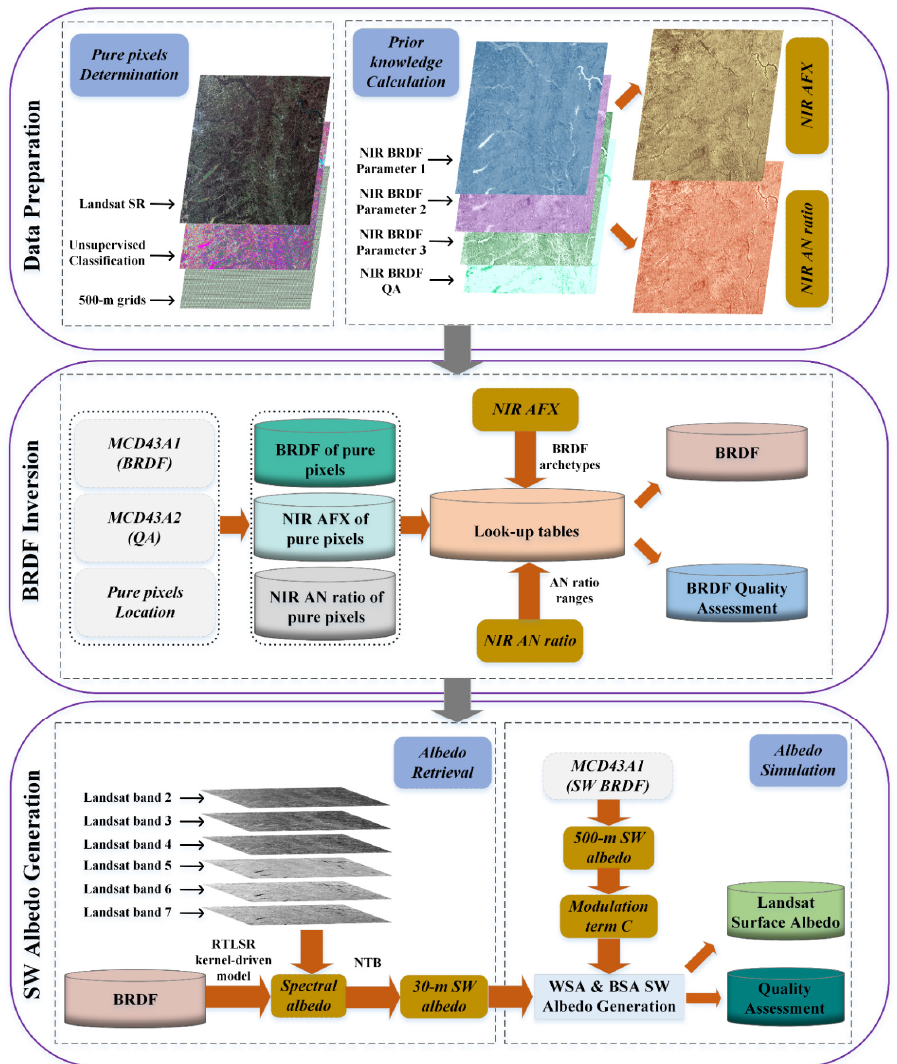
Figure 3. Flowchart for the Landsat/MODIS 30-m albedo retrievals.